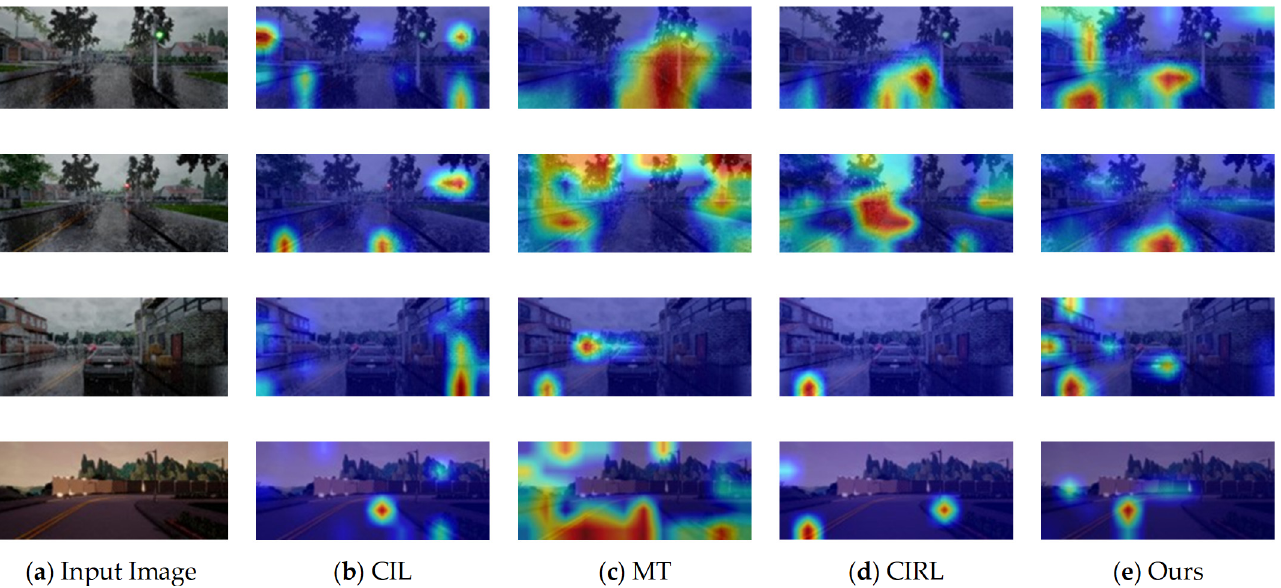
Figure 7. Qualitative Results Analysis by Grad-CAM Visualization.